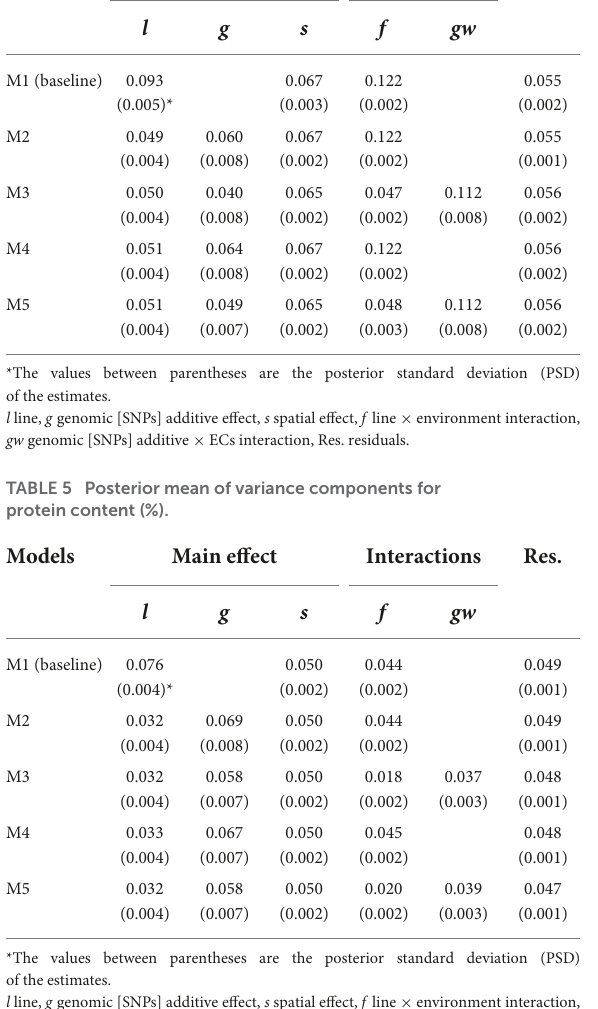
Figure 4 for grain yield and Figure 5 for protein content.